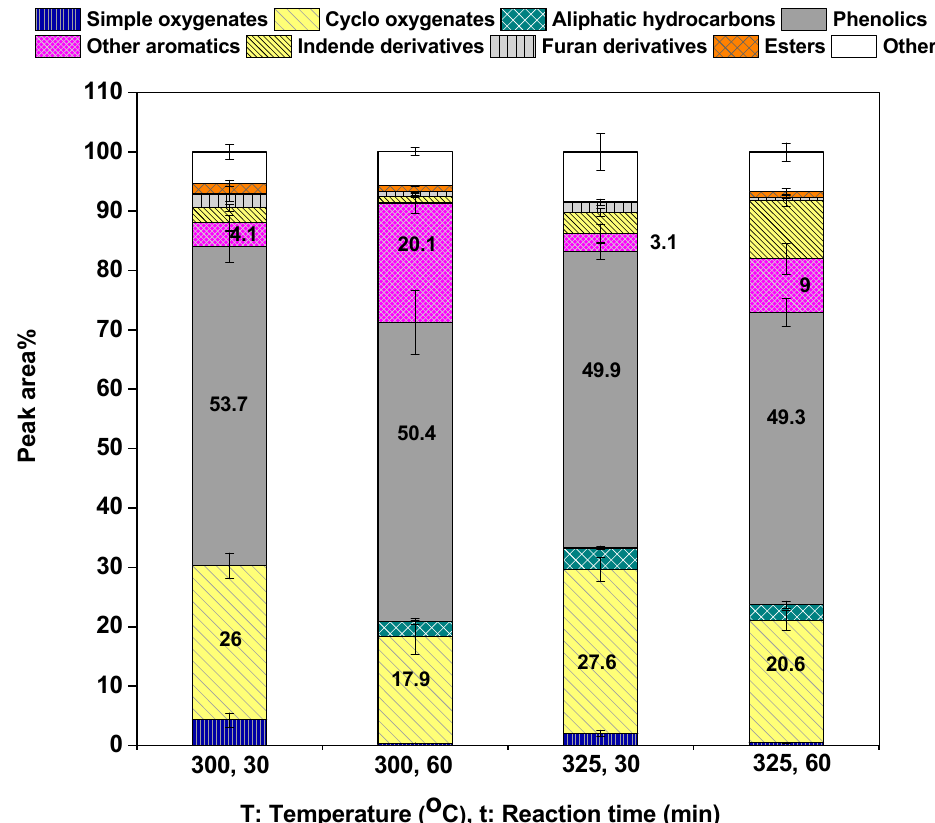
Figure 5. Selectivity to various functional groups in bio-crude obtained at rice-straw-to-water ratio of 1:10 wt./wt., at different operating conditions.